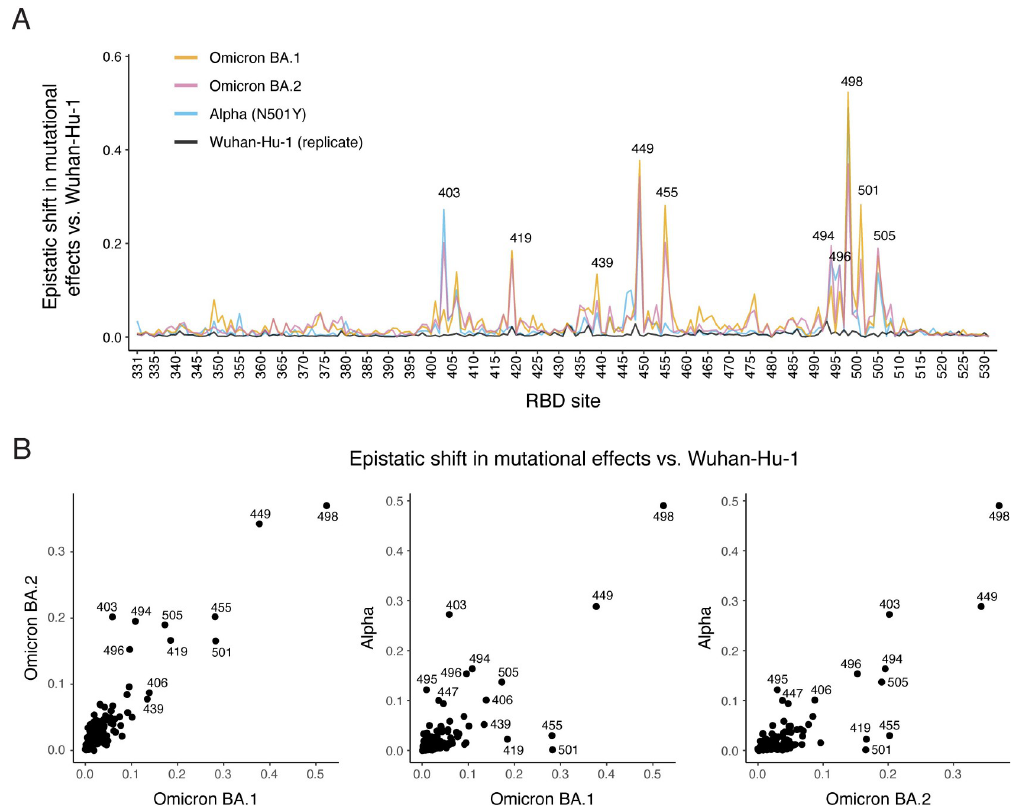
Fig 2. Epistatic shifts in mutational effects on ACE2 binding. (A) Epistatic shift in the effects of mutations on ACE2 binding at each RBD position compared to Wuhan-Hu-1. Interactive plot is available at https://jbloomlab.github.io/ SARS-CoV-2-RBD_DMS_Omicron/epistatic-shifts/. Alpha and Wuhan-Hu-1 (replicate) datasets are from previously described deep mutational scanning [10]. Epistatic shifts of all variants are shown in S4 Fig. Epistatic shift represents the Jensen-Shannon divergence in the Boltzmann-weighted affinities for all amino acids at each site. See S5 Fig for patterns of mutation-level shifts at relevant sites. (B) Scatterplots of epistatic shifts versus Wuhan-Hu-1 at each RBD position between Omicron BA.1, BA.2, and Alpha backgrounds. Points that fall off of the 1:1 line indicate sites where mutational effects diverge from Wuhan-Hu-1 in one background more than the other.